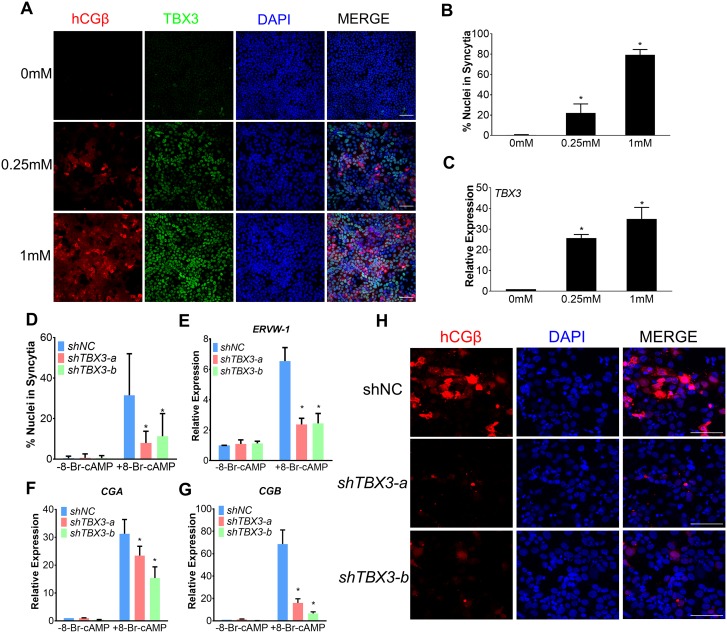
TBX3 regulated trophoblast cell differentiation into ST.(A) Immunofluorescence images of hCGβ (red) and TBX3 (green) showing ST cells formation under 0 mM, 0.25 mM, and 1 mM 8-Br-cAMP for 48 hours. (B) Graphical depiction of the percentage of nuclei associated with ST cells following exposure to different concentrations of 8-Br-cAMP for 48 hours. (C) qRT-PCR for TBX3 expression following exposure to different concentrations of 8-Br-cAMP for 48 hours. (D) The percentage of nuclei associated with fused cells. (E–G) qRT-PCR for ERVW-1 (E), CGA (F), and CGB (G) expression in JEG-3 cells expressing shNC, shTBX3-a, or shTBX3-b before and after 0.25 mM 8-Br-cAMP treatment for 48 hours. (H) Representative images of hCGβ expression in JEG-3 cells expressing shNC, shTBX3-a, or shTBX3-b cultured under 0.25 mM 8-Br-cAMP for 48 hours. Underlying data for all panels included in this figure can be found in S1 Data. *p < 0.05, n ≥ 3, mean ± SD. (scale bars = 100 μm.) cAMP, cyclic adenosine monophosphate; qRT-PCR, quantitative real-time PCR; ST, syncytiotrophoblast; TBX3, T-box transcription factor 3.